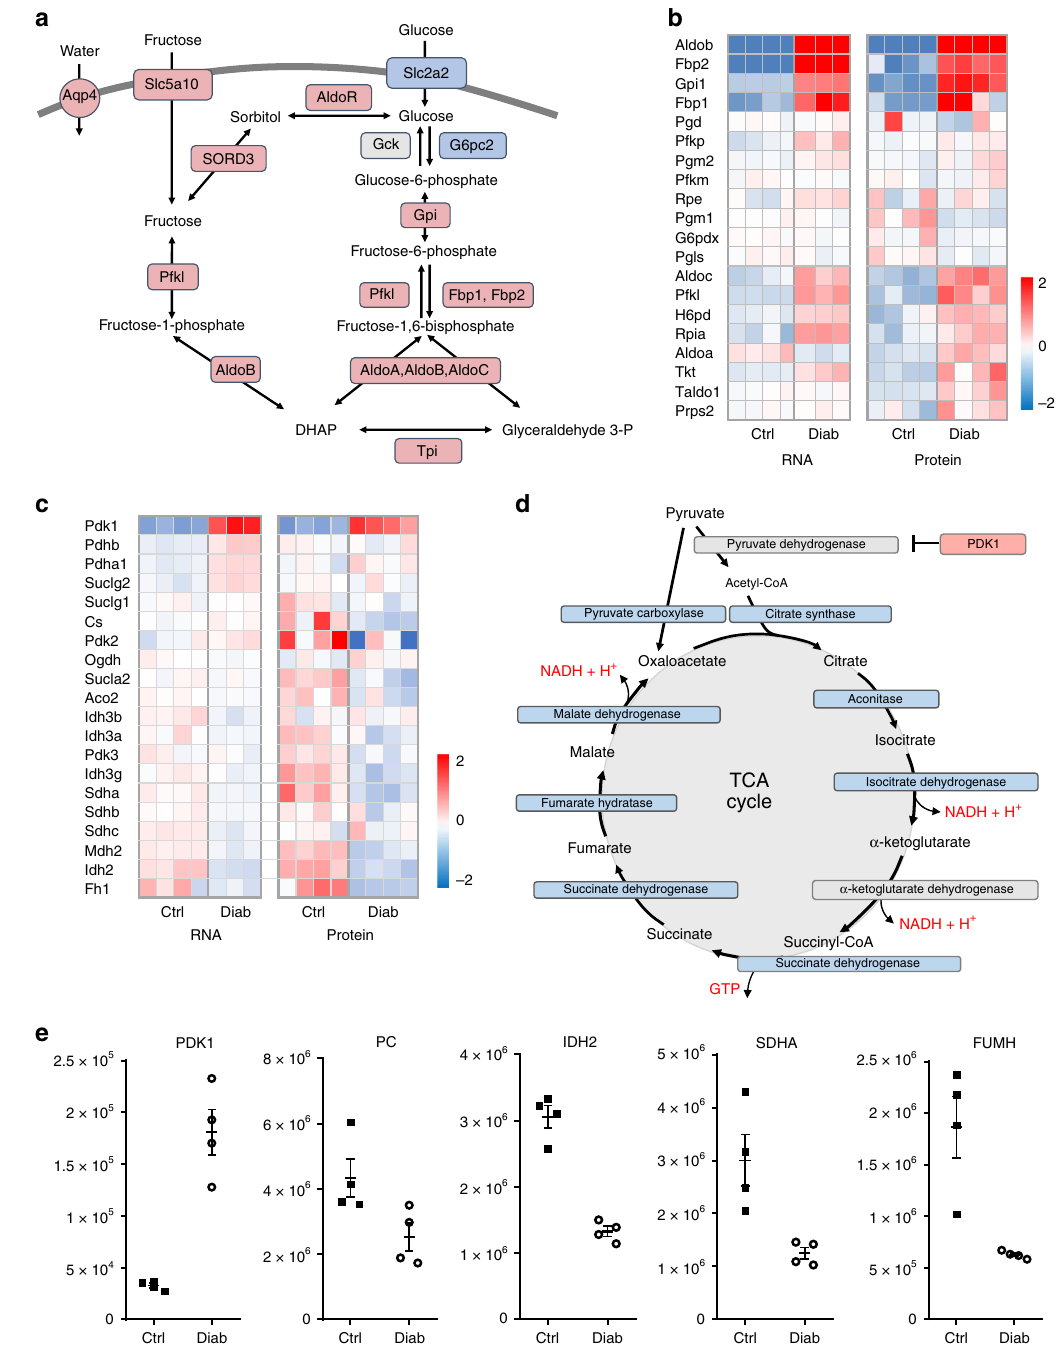
Fig. 2 Diabetes upregulates polyol pathway, pentose phosphate pathway and tricarboxylic acid (TCA) cycle genes and proteins. a Polyol pathway. Red, proteins upregulated in diabetes. Blue, proteins downregulated in diabetes. Grey, no change or not detected. AldoR, aldolase reductase. Slc2a2, glucose transporter 2. SORD3, sorbitol dehydrogenase. Aqp4, aquaporin 4. b Heat maps of mRNA and protein expression of the indicated genes in the pentose phosphate pathway in islets isolated from control (Ctrl) and 2-week diabetic β V59M (Diab) mice. Each box corresponds to a different animal. Colour indicates log 2 fold-change. c Heat maps of relative mRNA and protein levels of the indicated genes in islets isolated from control and 2-week diabetic β V59M mice. Each box corresponds to a different animal. Colour indicates log 2 fold-change. d TCA cycle. Red, proteins upregulated in diabetes; blue, proteins downregulated in diabetes. Grey, no change or not detected. PDK1, pyruvate dehydrogenase kinase 1. e Abundance of the indicated proteins, quanti fi ed by mass spectrometry, in islets isolated from control (black, Ctrl, n = 4) and 2-week diabetic β V59M (white, Diab, n = 4) mice. PDK1, pyruvate dehydrogenase kinase 1. PC, pyruvate carboxylase. IDH2, isocitrate dehydrogenase 2. SDHA, succinate dehydrogenase. FUMH, fumarate hydratase (mitochondrial). Each data point indicates a separate mouse. Mean ± s.e.m. is